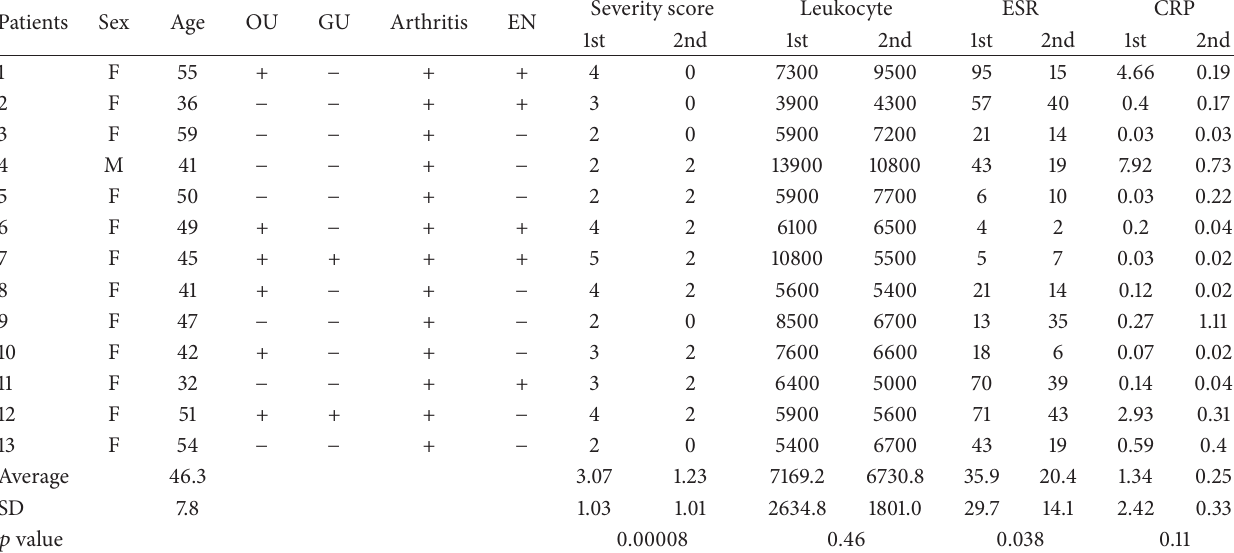
Table 1: Clinical characteristics of the 13 patients with Behc¸et’s disease.